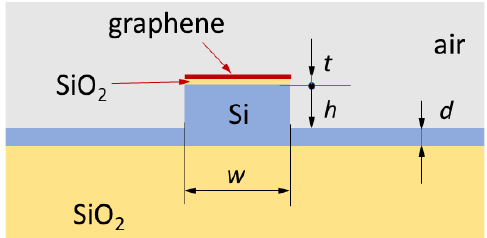
Fig. 1. Si rib waveguide modulator with a graphene